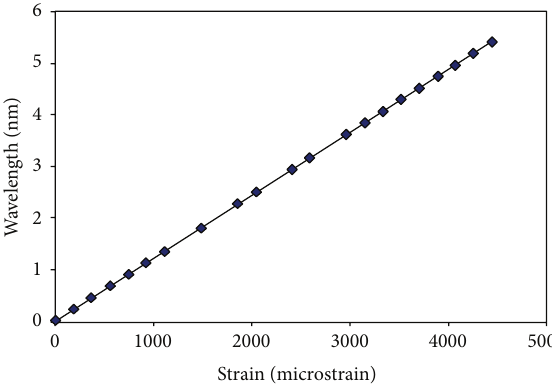
Figure 6: Temporal variation of Bragg wavelength and induced strain. Table 1: Values of water, strain, and Bragg reflections. Water loss (%)